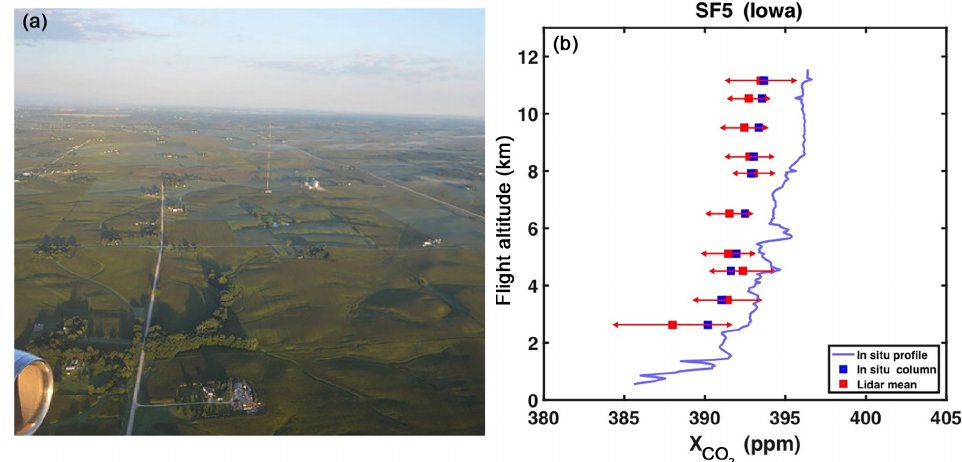
Figure 21. (a) Photo of the Iowa topography and the West Branch tower taken from the aircraft on 2014 SF5. (b) Summary of the in situ (blue) and the retrievals from the lidar measurement (red) vs. altitude. The lidar results are for retrievals based on 10s average from the altitude where the results are plotted, and the error bars are for 1 SD. The XCO 2 computed from the in situ sensor from the plotted altitude to the ground are shown as the blue dots. The in situ sensor shows the drawdown in CO 2 concentrations at lower altitudes caused by cropland, and that general trend is seen in the XCO 2 values computed from in situ and in lidar retrievals.